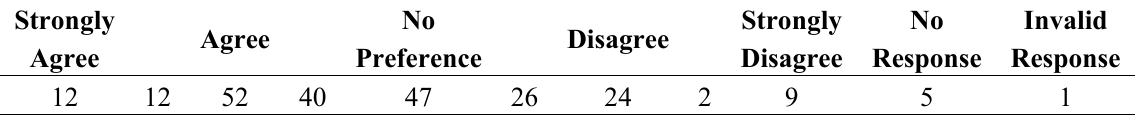
Table 10. Responses to the statement “I would trust a computer to prioritize data for transmission”.